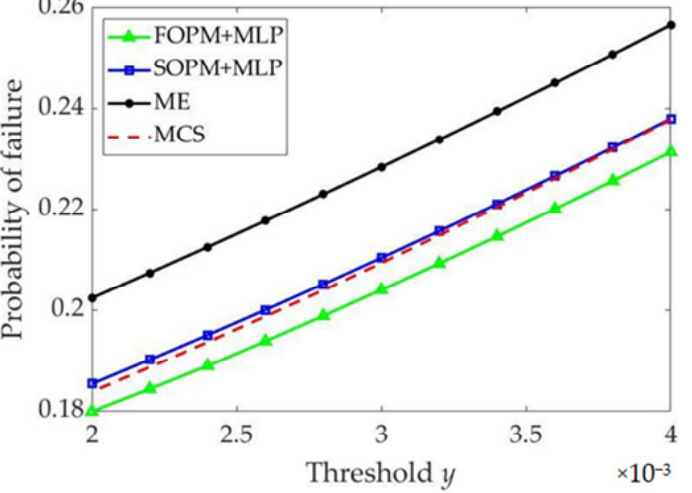
Figure 5. Comparison of the failure probabilities estimated by the different methods in Example 2.